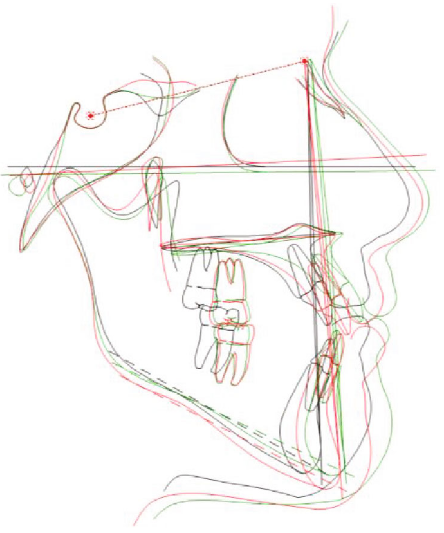
Figure 16: Case no. 2 tracing